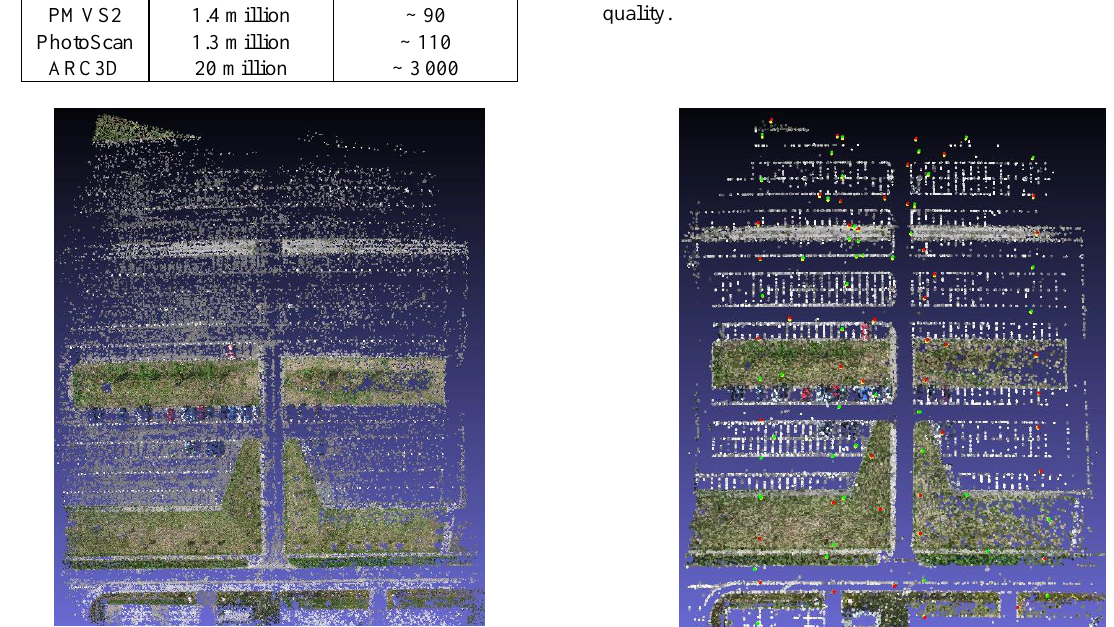
Figure 2. Point cloud generated with Photosynth (left) and Bundler (right)